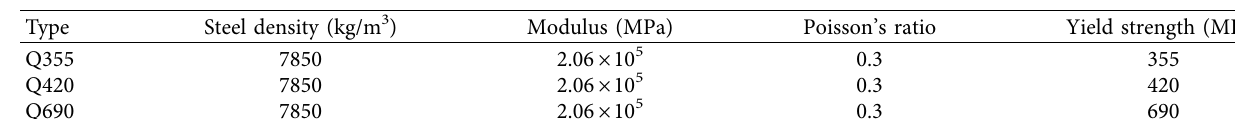
Table 3: Steel material parameters.